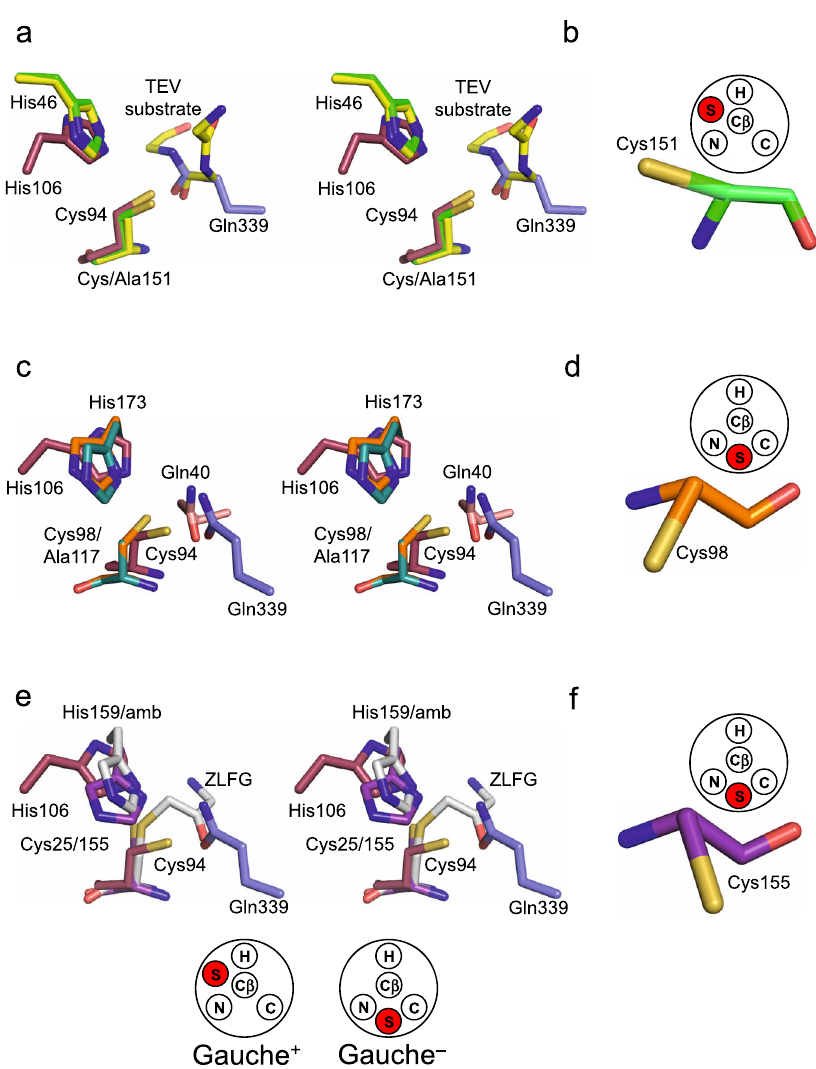
Fig. 4 The relative positions of the substrate and catalytic cysteines in WT BLF1:eIF4A Δ 20 model compared to other structures. a Stereo view of the active site of WT BLF1:eIF4A Δ 20 complex (BLF1; maroon, eIF4A; blue) superimposed with that of the TEV C151A protease with its substrate (PDB:1LVB; yellow), and with the WT TEV protease (PDB:1LVM; green). The target carboxamide group of the side chain of Gln339 of eIF4A (blue) superposes well with the scissile peptide of the TEV substrate (yellow). The superposition shows that the nucleophilic cysteine of TEV and BLF1 approach the re face of their respective substrates. b Cys151 of TEV showing it adopts the gauche + conformation. c Stereo view of the local superposition between the WT BLF1:eIF4A Δ 20 complex (BLF1; maroon, eIF4A; blue) and the Cif C117A:NEDD8 complex (PDB:4F8C (Cif; teal, Nedd8 substrate; pink)), and AvrPphB (PDB:1UKF; orange), maximizing the overlap of their Cys/His pairs. The superposition shows that the nucleophilic cysteine of Cif approaches the si face of Gln40 Nedd8 substrate, compared to the re face seen in the BLF1:eIF4A Δ 20 complex. d Cys98 of the Cif-like protease AvrPphB showing it adopts a gauche